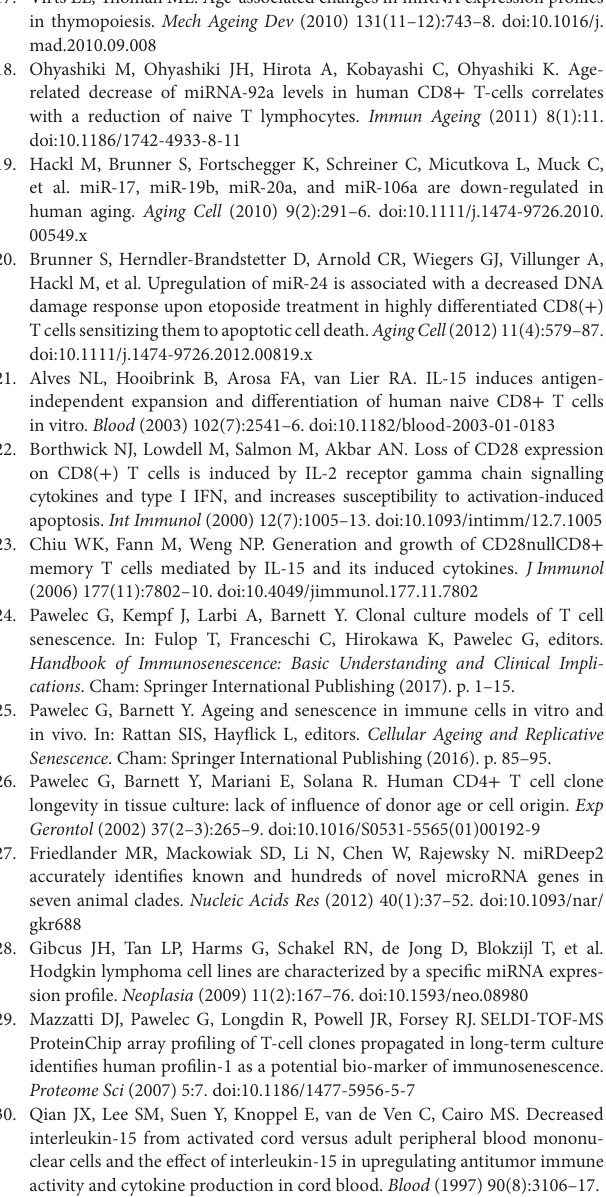
FigUre s1 | Sorting strategy of CD8 + CD45RO − CCR7 + CD28 + T cells. FigUre s2 | Loss of CD28 expression after 15 days culture with IL-15. Fluorescence-activated cell sorting-sorted naïve CD8 + CD45RO − CCR7 + CD28 + T cells were stained with proliferation dye to study CD28 expression after proliferation upon IL-15 stimulation (50 ng/ml). Proliferation of the naïve CD8 T cells was assessed after 15 days of culture. (a) Gate setting for the identification of the population doublings (PDs). Within the different PDs,